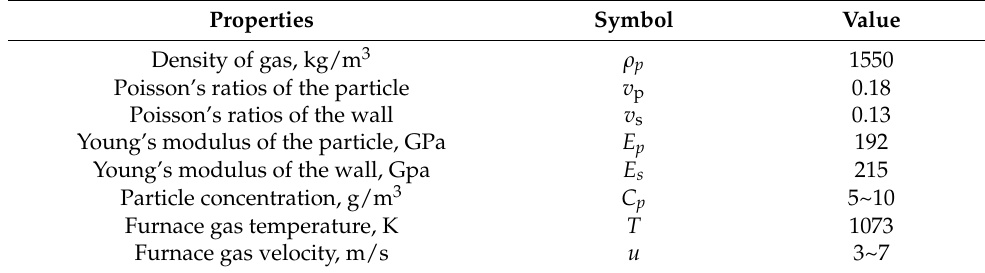
Table 3. Physical properties of the deposition model.